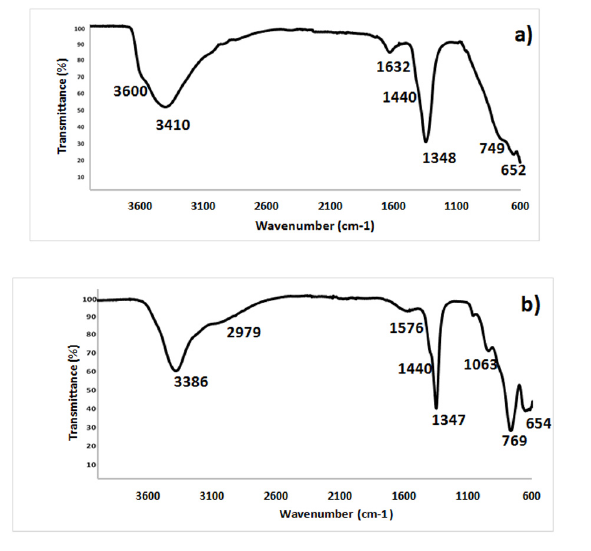
Figure 2. FTIR spectra of ( a ) the NiAl nitrate LDH, ( b ) the MgAl carbonate LDH. − 1 Sample (a): A 3600 cm OH group stretching, 3410 cm